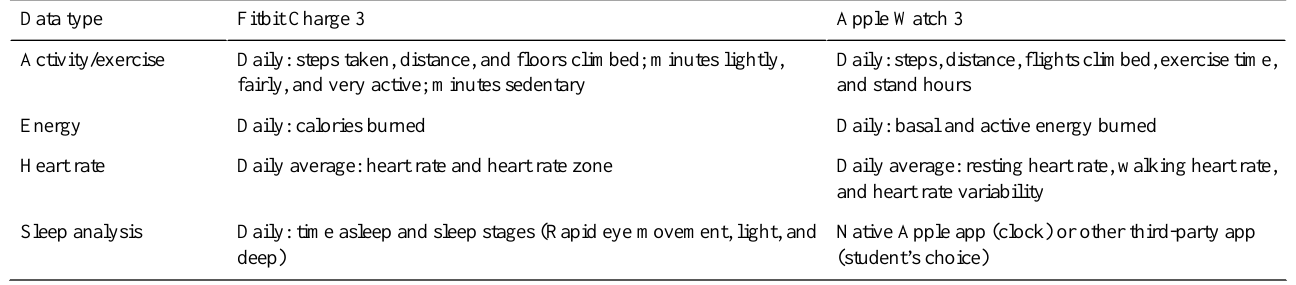
Table 1. Mobile device data collection.